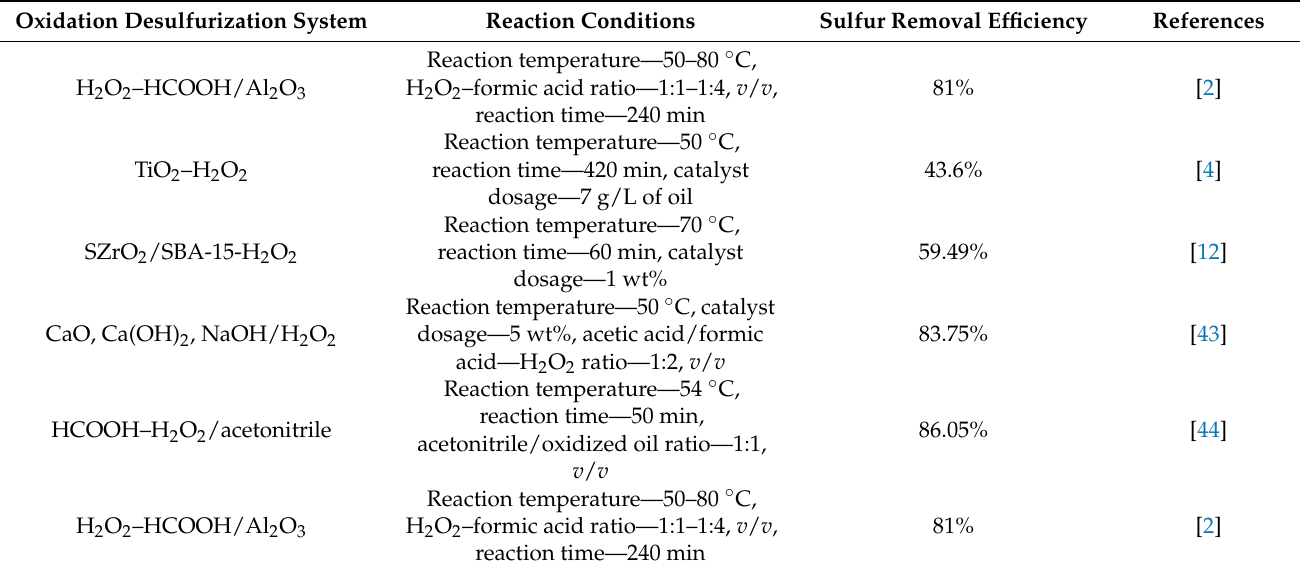
Table 3. The various ODS methods used to remove sulfur from